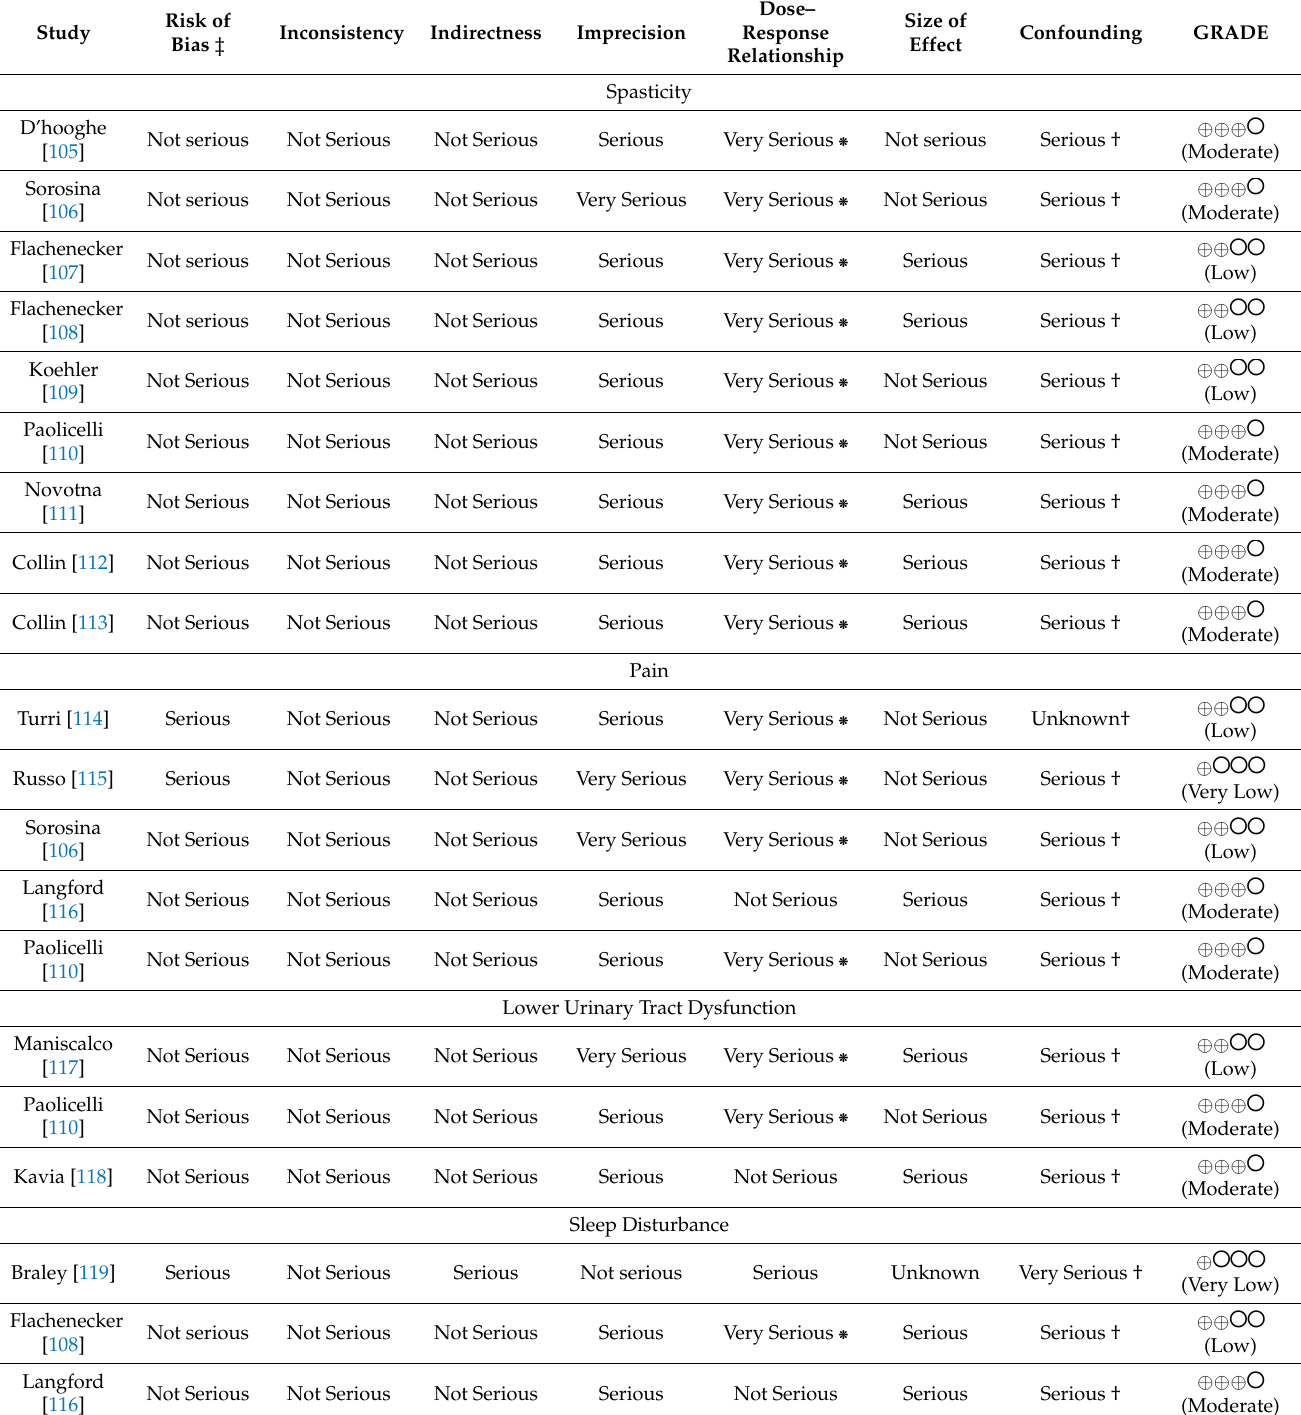
Table 7. Certainty of evidence.